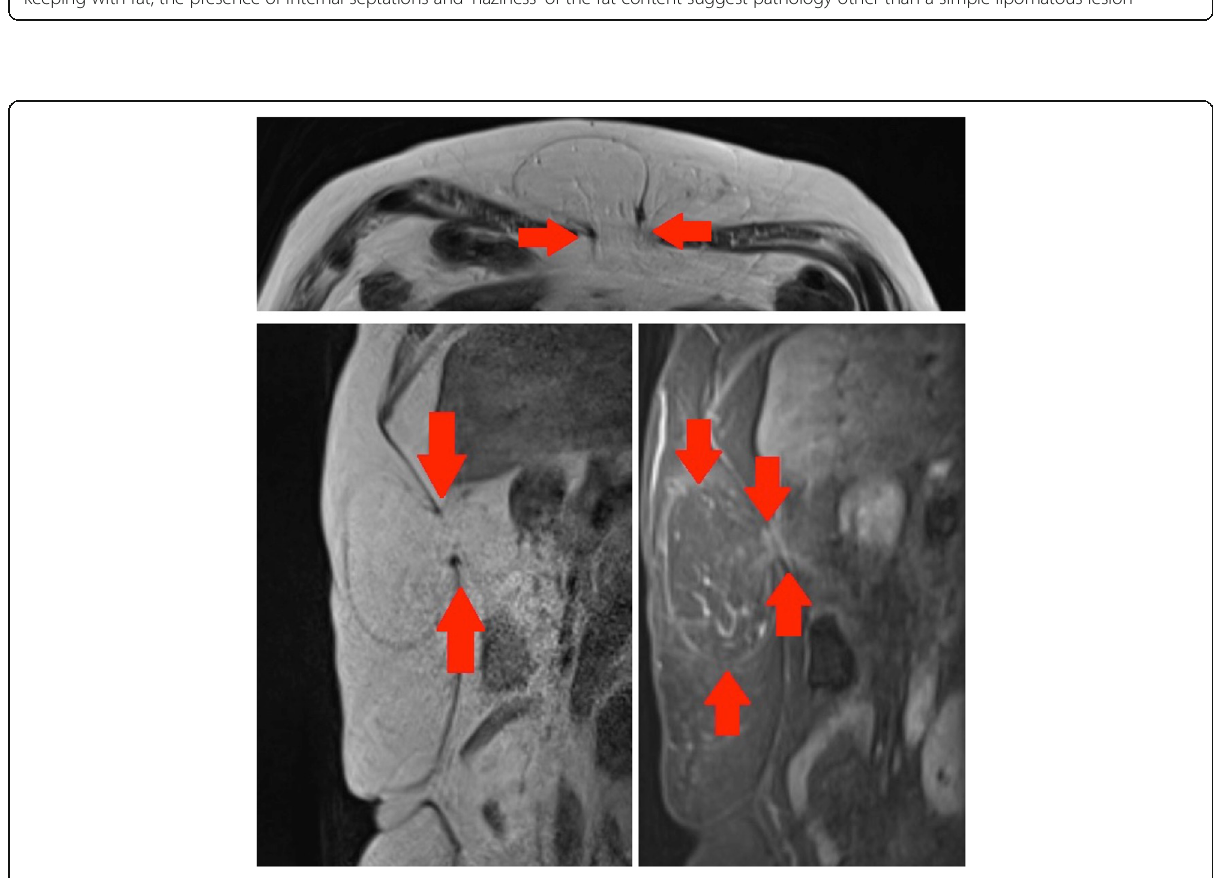
Fig. 5 Top panel: Axial T1-weighted image of the upper abdomen: arrows delineate the defect in the anterior abdominal wall. The hernia sac contains fat with internal striations. Bottom left panel: Sagittal T1-weighted image of the upper abdomen: demonstrates an epigastric hernia with the hernial neck outlined by the red arrows. The hernial sac contents are of fat signal intensity and histology proved to be in keeping with ALT. Bottom right panel: Sagittal T1 TIRM-weighted image of the upper abdomen: Red arrows outline the epigastric hernia which demonstrates suppression on fat saturated sequences confirming the presence of a fat containing tumour. The presence of high signal septae suggests an atypical lipomatous tumour